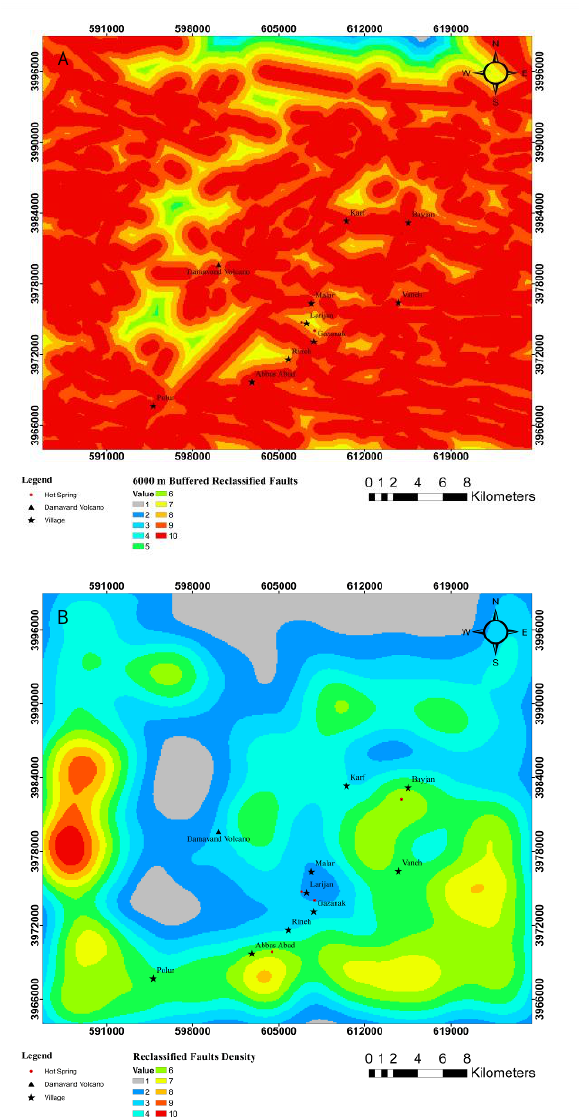
Figure 6. Structural Factor Classified map A) Distribution of the faults after 6000 m buffering. B) Faults density in study Figure 5. Remote Sensing Factor Classified map A) The alteration distribution obtained from ASTER images. B) The Land Surface Temperature after extract anomaly points and 3000 m buffering